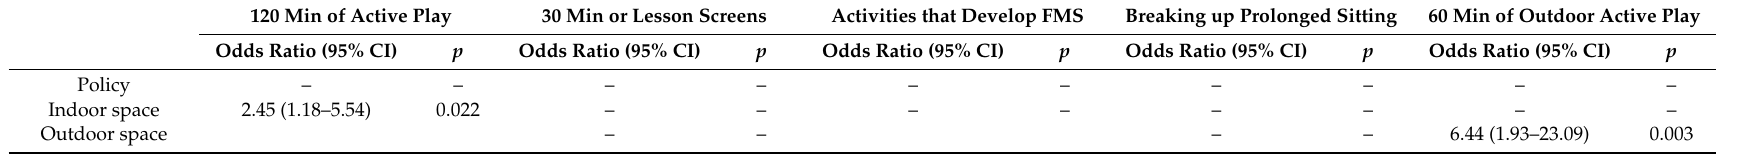
Table 5. Policy and environmental correlates of Active Play standards for the sample of childcare facility managers matched with sta ff responses.